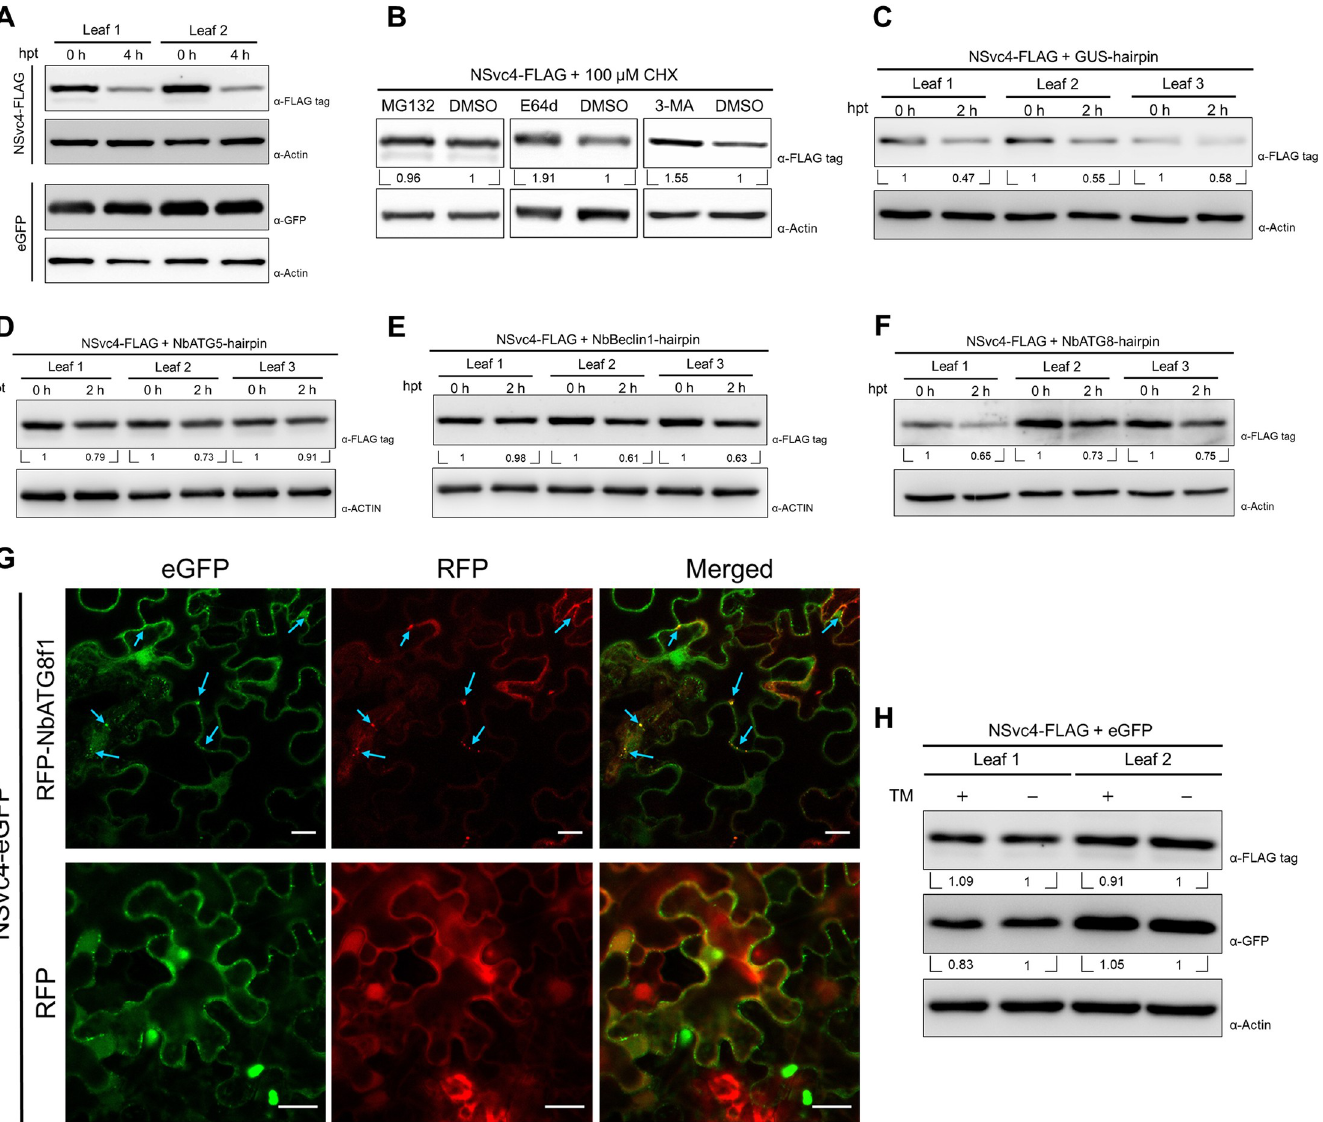
Fig 2. NSvc4 is unstable in plant cells and degraded through the autophagy pathway. (A) In vivo protein stability assay of NSvc4. The leaves expressing NSvc4-FLAG or eGFP were treated with 100 μ M CHX. Samples were harvested at 0 h and 4 h after treatment for western blotting. Actin was used as a loading control. (B) Protease inhibitors treatment of the leaves expressing NSvc4-FLAG. The leaves expressing NSvc4-FLAG were treated with 100 μ M CHX together with MG132, E64d, 3MA, or DMSO, respectively. Six hours later, the leaves were harvested, and total protein was extracted for western blotting. Actin was used as a loading control. The relative levels of NSvc4-FLAG to Actin were calculated and normalized by setting values in DMSO treatment as 1.0. (C-F) In vivo protein degradation rate assay of NSvc4 upon silencing NbATG5 , NbBeclin1 or NbATG8 . The leaves expressing NSvc4-FLAG with GUS-hairpin (C), NbATG5-hairpin (D), NbBeclin1-hairpin (E) or NbATG8-hairpin (F) were treated with CHX. Samples were harvested at 0 h and 2 h after treatment for western blotting. Actin was used as a loading control. The relative levels of NSvc4-FLAG to Actin were calculated and normalized by setting values at 0 h as 1.0. (G) Confocal images of NSvc4-eGFP co-expressed with RFP-NbATG8f1. N . benthamiana leaves were infiltrated with agrobacteria carrying NSvc4-eGFP and RFP-NbATG8f1 or RFP. Arrows indicate colocalized eGFP and RFP fluorescence. Bars, 20 μ m. ( H ) Western blotting analysis of NSvc4-FLAG after TM treatment in N . benthamiana leaves. NSvc4-FLAG and eGFP were co-expressed in N . benthamiana leaves by agroinfiltration. Then, the leaves were treated with TM at 42 hpi. Eighteen hours later, total protein was extracted for western blotting analysis. The relative levels of NSvc4-FLAG to Actin were calculated and normalized by setting values in DMSO control as 1.0. https://doi.org/10.1371/journal.ppat.1009370.g002 with TM. Then, the total protein was extracted for western blotting analysis. As expected, the TM treatment did not have obvious effects on the protein level of eGFP. Unexpectedly, the protein level of NSvc4-FLAG did not decrease significantly after TM treatment (Fig 2H),